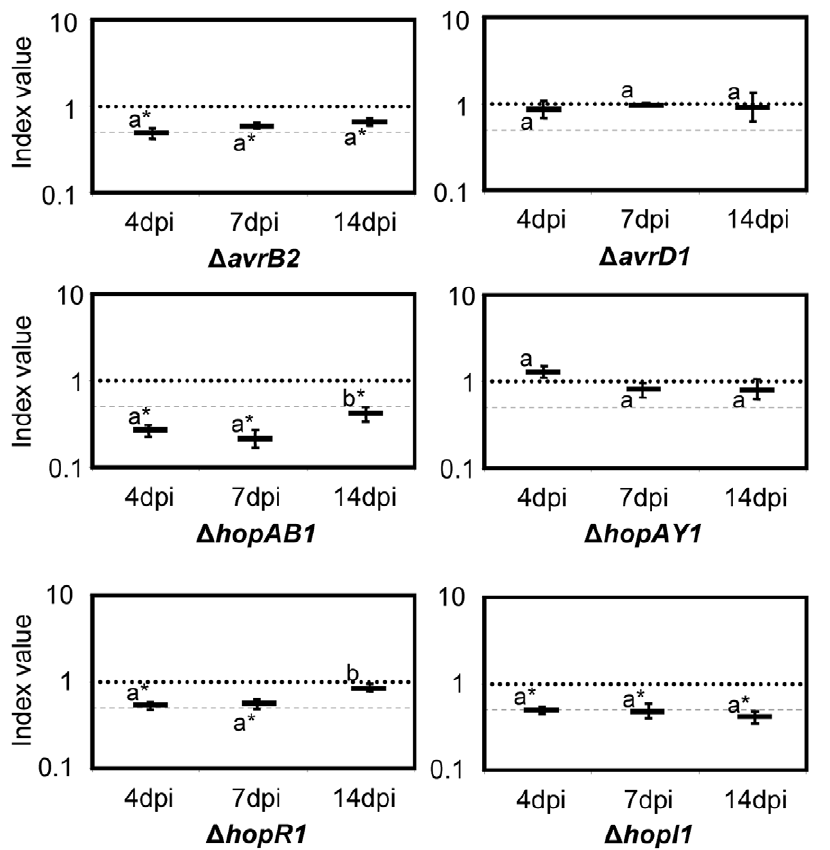
Figure 6. Competitive Index analysis of Pph 1448a effector mutants following dip-inoculation. Mutant strains were co-inoculated with the wild type strain, and samples were taken at different time points (4, 7 and 14 days post-inoculation, dpi) as indicated. Competitive indices correspond to the mean of two to three independent experiments with three replicates per experiment. A dashed line corresponding to a CI=0.5 is included for reference. Error bars represent the standard error. Asterisks indicate results significantly different from one, as established by Student’s t- test (P , 0.05). Mean values marked with the same letter (a or b) indicate results not significantly different from each other, as established by One Way ANOVA and Holm-Sidak test for multiple comparison ( P , 0.05).